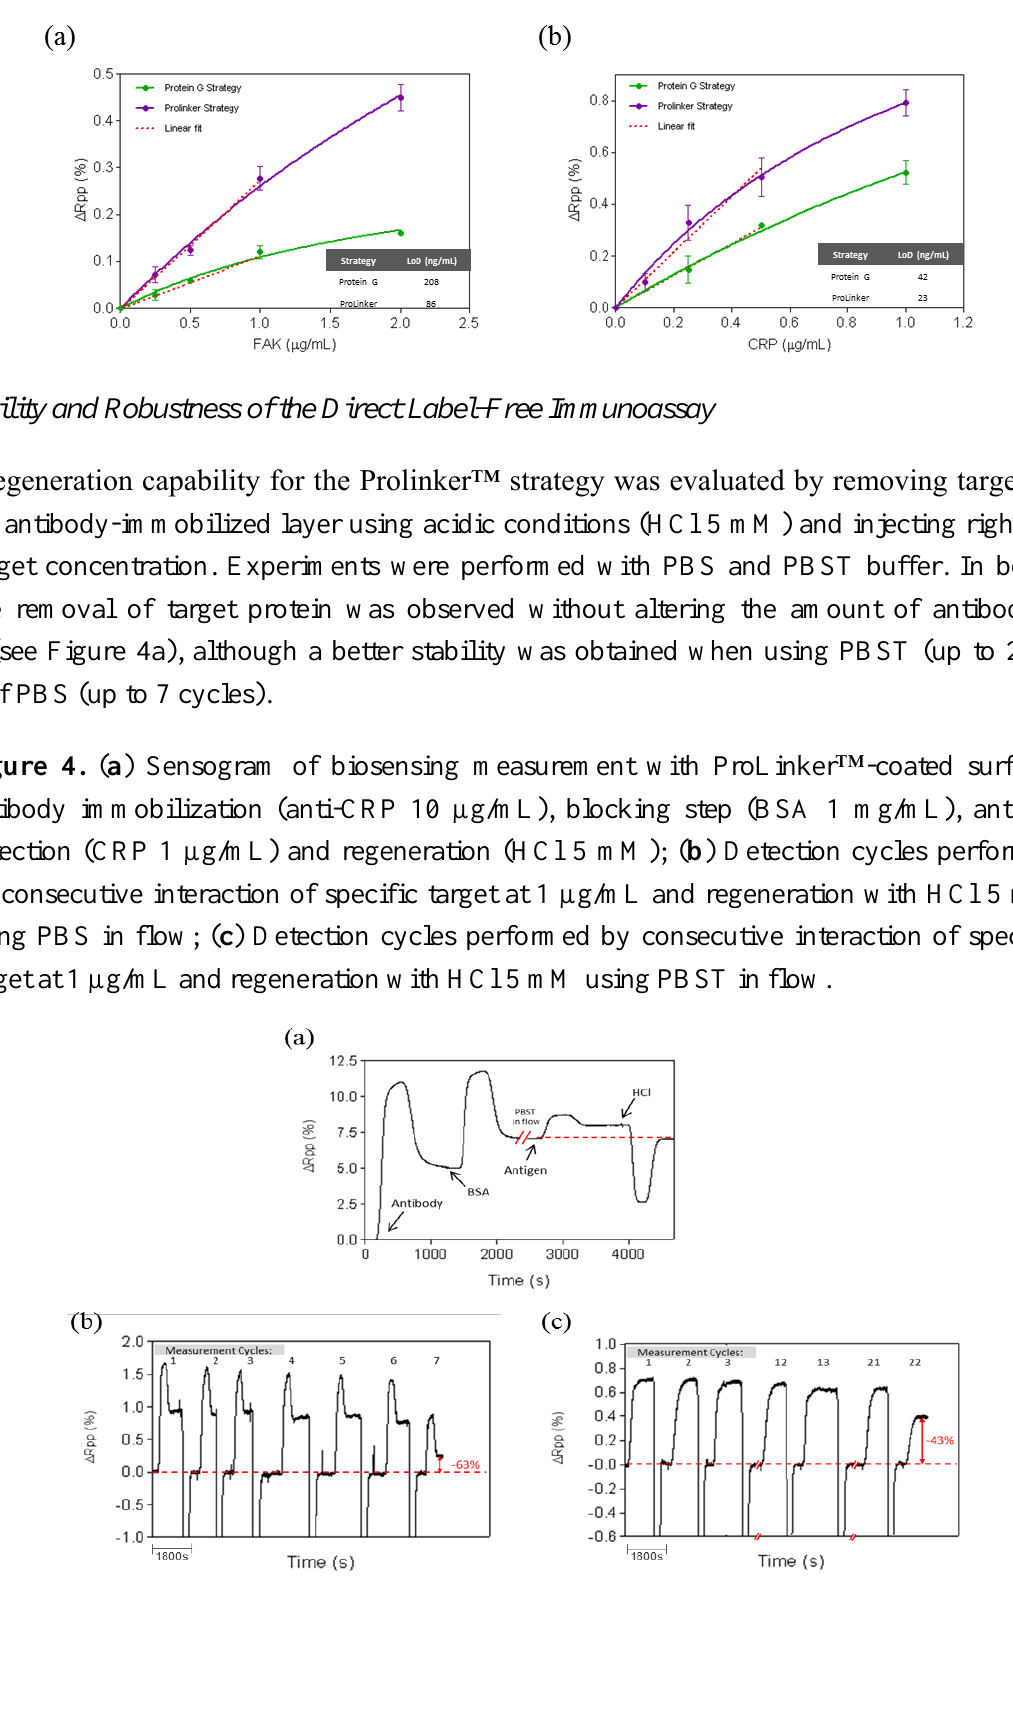
Figure 3. Calibration curves for ( a ) FAK protein and ( b ) CRP protein, performed with 10 µg/mL of specific antibody and following both Protein G strategy (green) and ProLinker™ strategy (purple). Dashed red lines represent linear fit of the linear region of the curves.